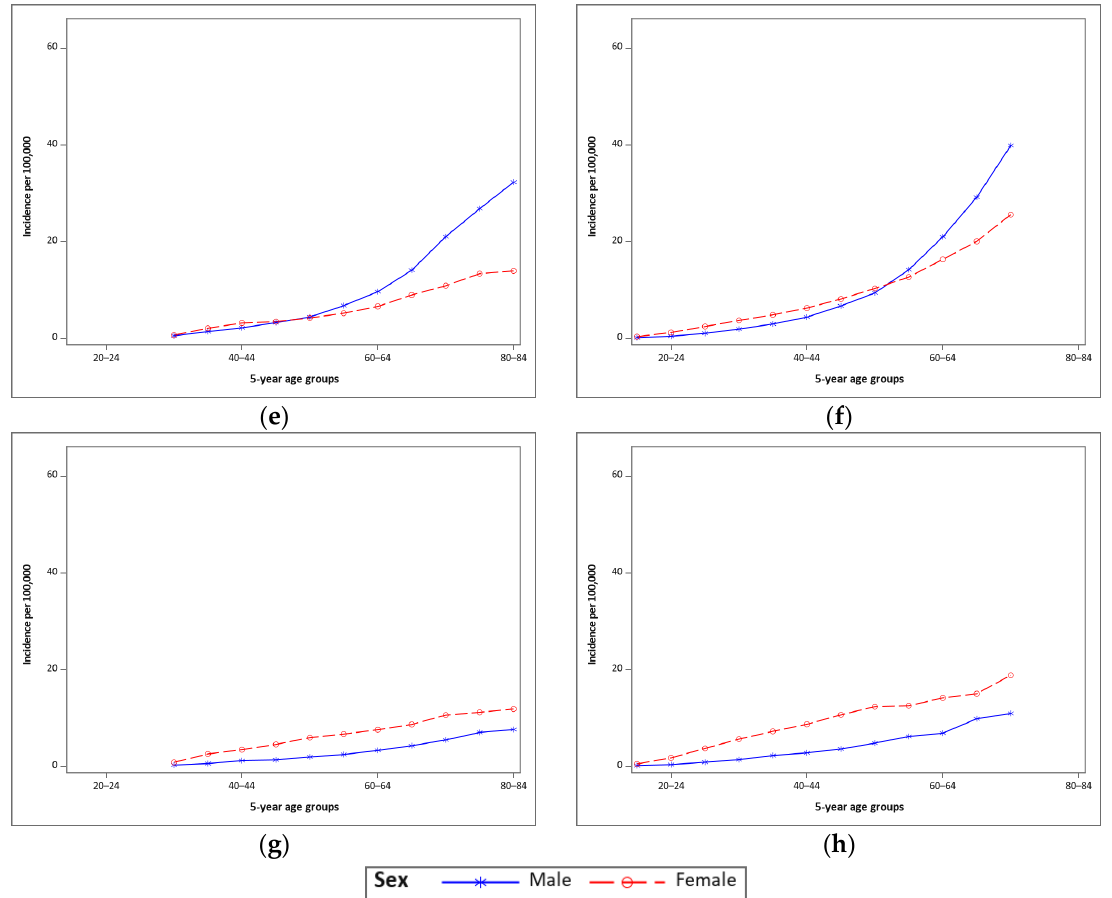
Figure 4. Incidence of malignant melanoma of four anatomic sites for 5-year age groups by sex and birth year. ( a ) head